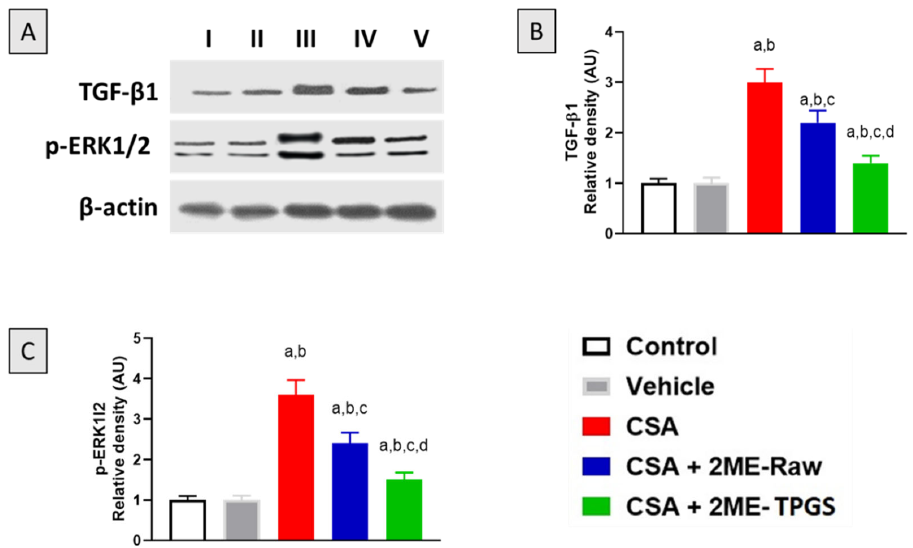
Figure 7. Effect of 2-ME-TPGS on TGF- β 1 and phosphorylated ERK1/2 expression in renal tissues of CSA-challenged rats ( A – C ). Data in bar charts are shown as mean ± SD ( n = 6). a, b, c, or d: significantly different when compared with respective Control, Vehicle, CSA, or CSA + 2ME-Raw at p < 0.05, respectively.